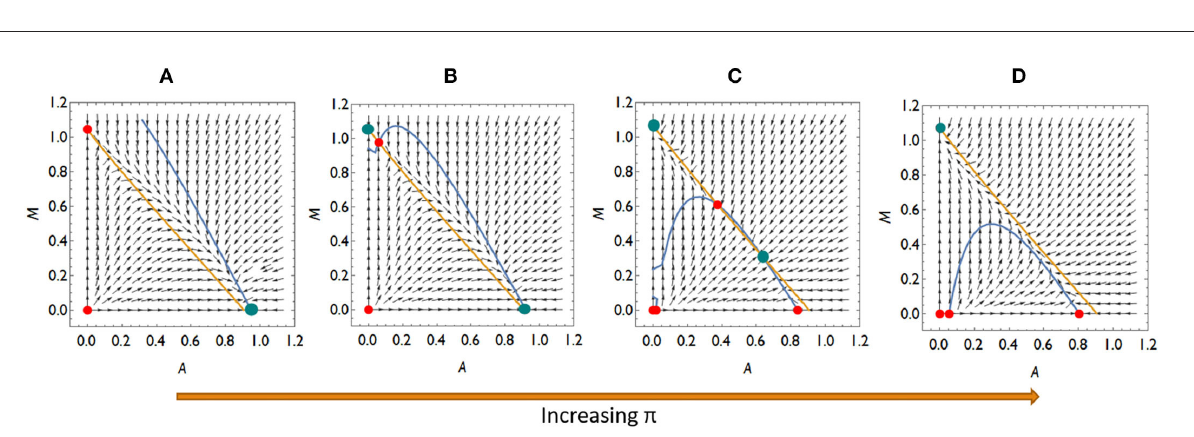
FIGURE4 The qualitatively different dynamics of the Mycoplasma–Aliivibrio system when Aliivibrio deteriorate Mycoplasma living conditions. The nullclines of (A,B) are depicted (yellow dM/dt = 0, blue dA/dt = 0), so their intersections define the fixed points of the dynamics. Red points denote the unstable, while green points denote the stable fixed points of the system. At low relative immune efficiency ( π ) Aliivibrio dominates the dynamics (A) . At intermediate π the system is bistable (B,C) , while at high π Mycoplasma dominates the dynamics (D) . Parameters: (A) π = 0.4, (B) π = 0.6, (C) π = 1.1, (d) π = 1.3, other parameters are the same for all subfigures: r A = r M = 1, a AM = 0.5 a MA = 1.1, ε = 0.1, σ = 0.5, δ = 0.1, β = 0.5, µ = 7 .